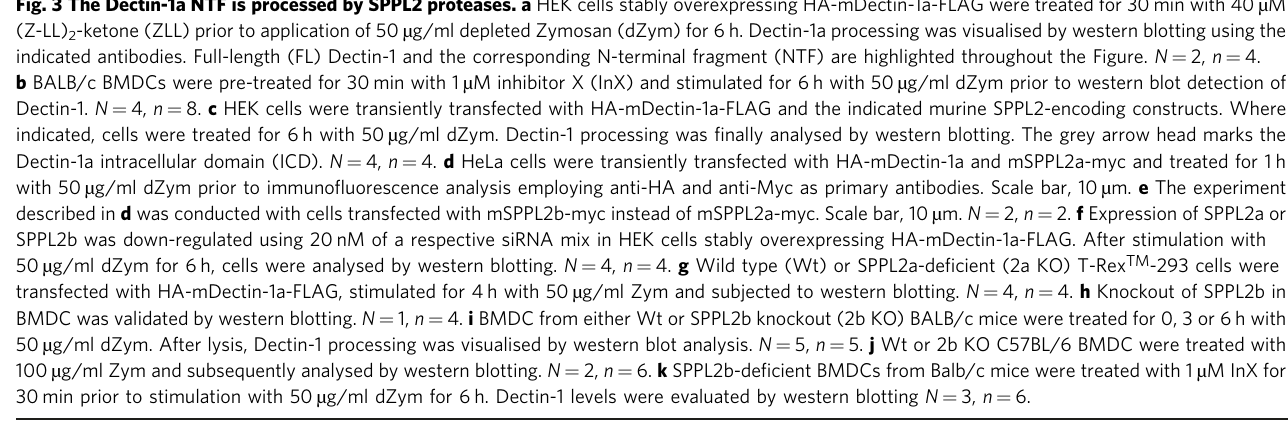
Fig. 3 The Dectin-1a NTF is processed by SPPL2 proteases. a HEK cells stably overexpressing HA-mDectin-1a-FLAG were treated for 30 min with 40 µ M (Z-LL) 2 -ketone (ZLL) prior to application of 50 µ g/ml depleted Zymosan (dZym) for 6 h. Dectin-1a processing was visualised by western blotting using the indicated antibodies. Full-length (FL) Dectin-1 and the corresponding N-terminal fragment (NTF) are highlighted throughout the Figure. N = 2, n = 4. b BALB/c BMDCs were pre-treated for 30 min with 1 µ M inhibitor X (InX) and stimulated for 6 h with 50 µ g/ml dZym prior to western blot detection of Dectin-1. N = 4, n = 8. c HEK cells were transiently transfected with HA-mDectin-1a-FLAG and the indicated murine SPPL2-encoding constructs. Where indicated, cells were treated for 6 h with 50 µ g/ml dZym. Dectin-1 processing was fi nally analysed by western blotting. The grey arrow head marks the Dectin-1a intracellular domain (ICD). N = 4, n = 4. d HeLa cells were transiently transfected with HA-mDectin-1a and mSPPL2a-myc and treated for 1 h with 50 µ g/ml dZym prior to immuno fl uorescence analysis employing anti-HA and anti-Myc as primary antibodies. Scale bar, 10 µ m. e The experiment described in d was conducted with cells transfected with mSPPL2b-myc instead of mSPPL2a-myc. Scale bar, 10 µ m. N = 2, n = 2. f Expression of SPPL2a or SPPL2b was down-regulated using 20 nM of a respective siRNA mix in HEK cells stably overexpressing HA-mDectin-1a-FLAG. After stimulation with 50 µ g/ml dZym for 6 h, cells were analysed by western blotting. N = 4, n = 4. g Wild type (Wt) or SPPL2a-de fi cient (2a KO) T-Rex TM -293 cells were transfected with HA-mDectin-1a-FLAG, stimulated for 4 h with 50 µ g/ml Zym and subjected to western blotting. N = 4, n = 4. h Knockout of SPPL2b in BMDC was validated by western blotting. N = 1, n = 4. i BMDC from either Wt or SPPL2b knockout (2b KO) BALB/c mice were treated for 0, 3 or 6 h with